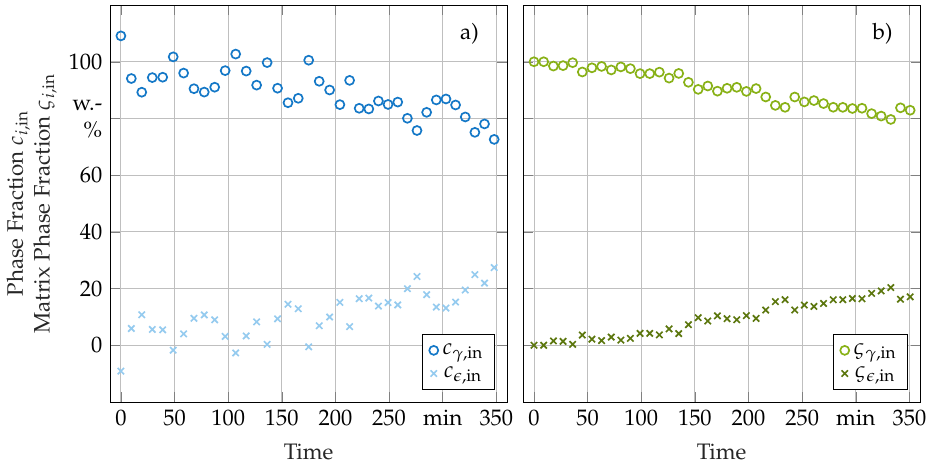
Figure 9. Calculated weight fractions c i ,in and weight fractions relative to the matrix phases ς i ,in over the time spent in the HT based on the in-situ XRD measurements for ( a ) sample 1 and ( b ) sample